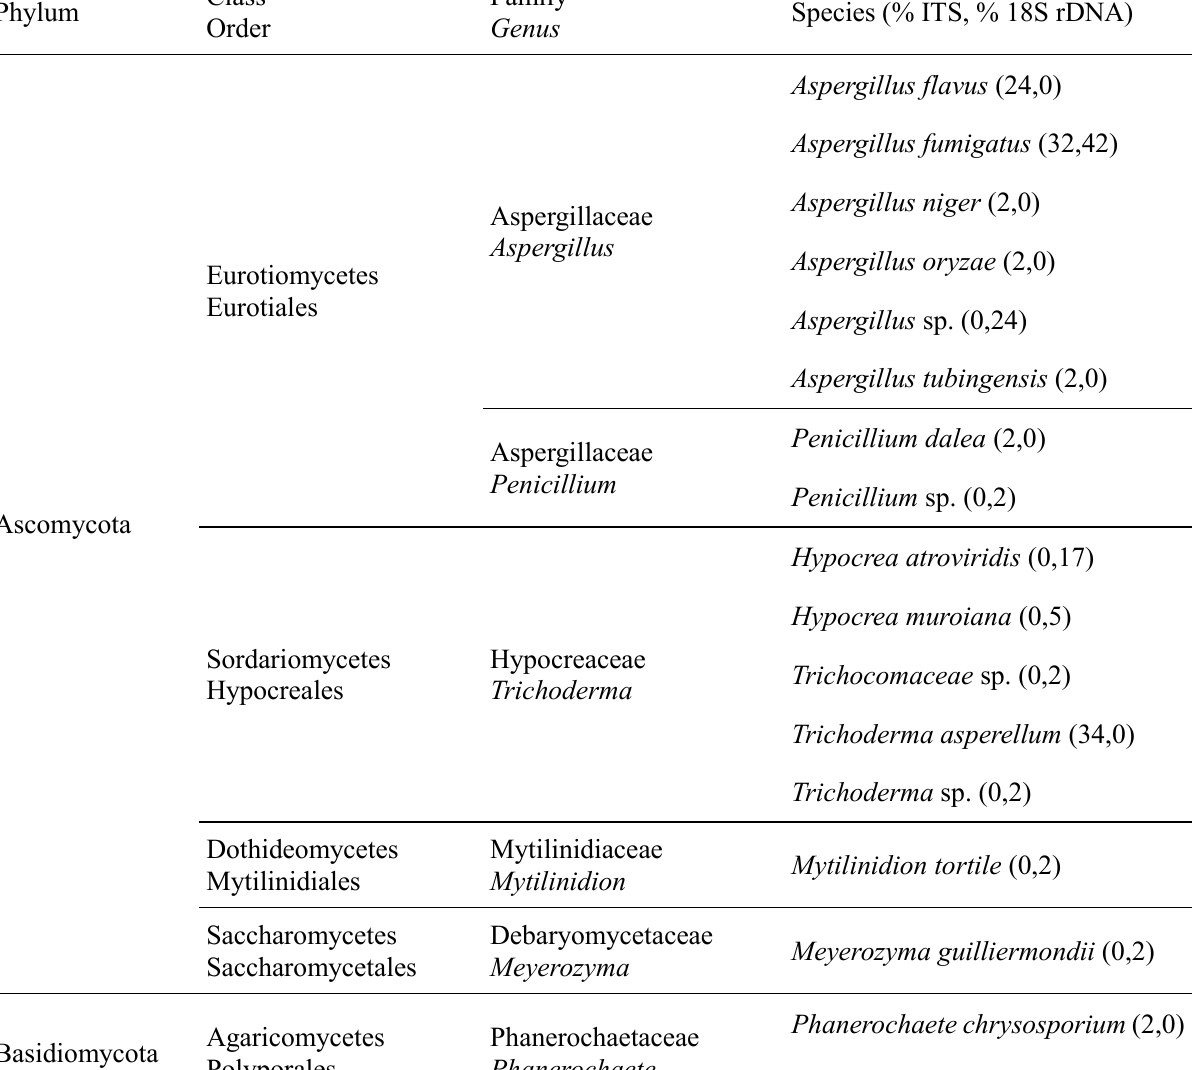
Table 3. Taxonomic affiliations of the sequenced fungal species.